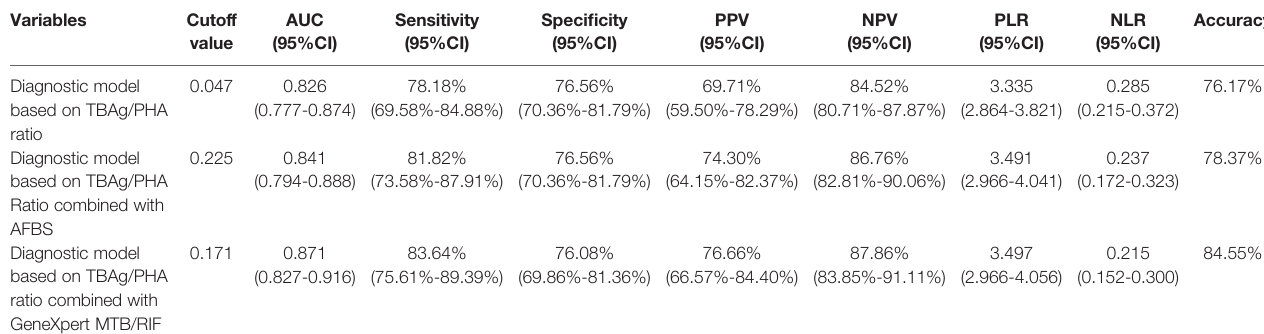
TABLE 2 | The predicting performance of various diagnostic methods for distinguishing between TB and NTB in the training cohort (Tongji